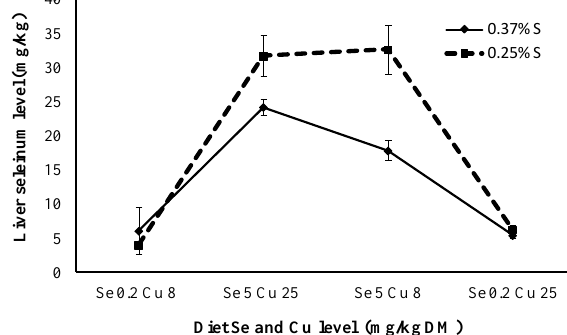
Figure 1. Liver selenium concentration of lambs with different levels of selenium and copper in the